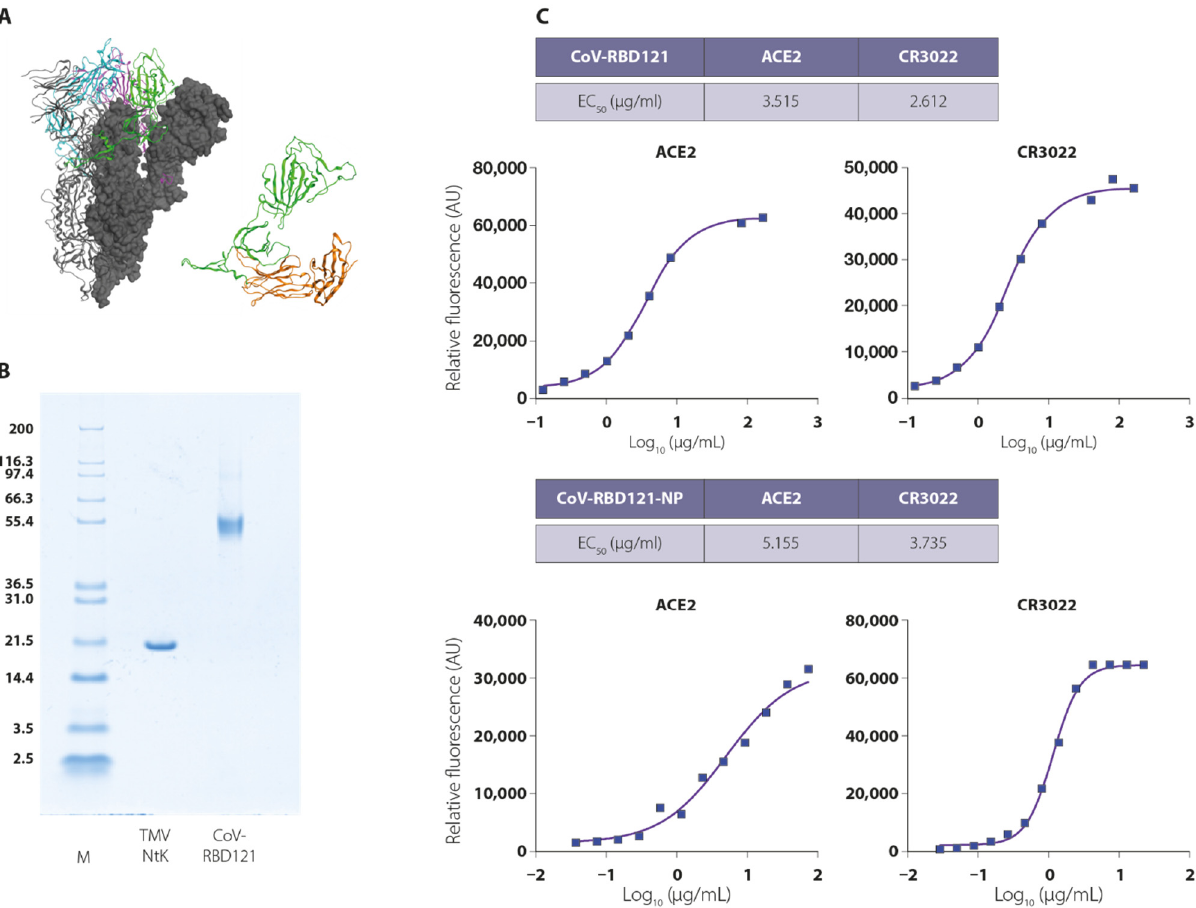
Figure 1. Potency of the CoV-RBD121-NP for ACE2 and the antibody CR3022. ( A ) Structural basis of the antigen based on S of SARS-CoV-2. (Left) SARS-CoV-2 S trimer is shown in ribbon and surface representation (PDB ID:6X6P). RBDs are colored green, magenta, and blue. (Right) Structure of the CoV-RBD121 antigen modeled with Molecular Operating Environment (MOE) software. The RBD (green) is amino acids 331-632 of SARS-CoV-2 S protein (PDB: 6X6P) and the Fc portion (orange) is from human IgG (PDB ID: 1HZH). ( B ) Purity of the TMV NtK virion (18.1 kDa) and of the CoV-RDB121 antigen (59.4 kDa) prior to conjugation as assessed by Coomassie staining of proteins separated by reducing SDS-PAGE. M indicates molecular markers. ( C ) Conformation and potency of the CoV-RBD121 antigen and the conjugated vaccine NP as assessed by binding to ACE2 and the monoclonal antibody CR3022.